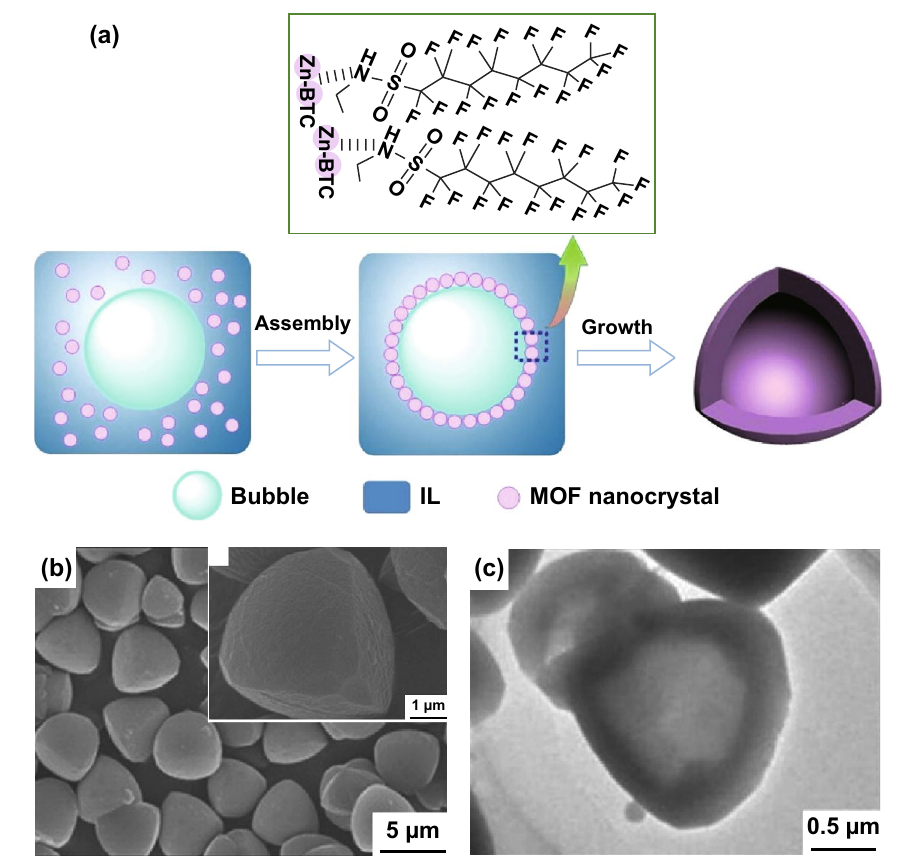
Fig. 15 a Schematic illustration for the formation of hollow Zn–BTC tetrahedroids via a CO 2 –IL interfacial templating route. b SEM and c TEM images of the hollow tetrahedron-like Zn–BTC microparticles. The N-EtFOSA concentration is 2.0 wt% based on IL and the CO 2 pressure is 6.3 MPa. Reprinted with permission from Ref. [113]. Copyright 2014 Elsevier